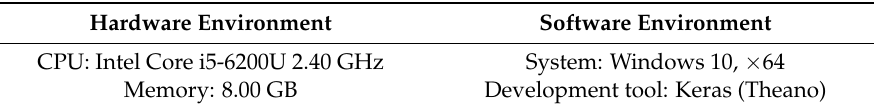
Table 2. The experimental